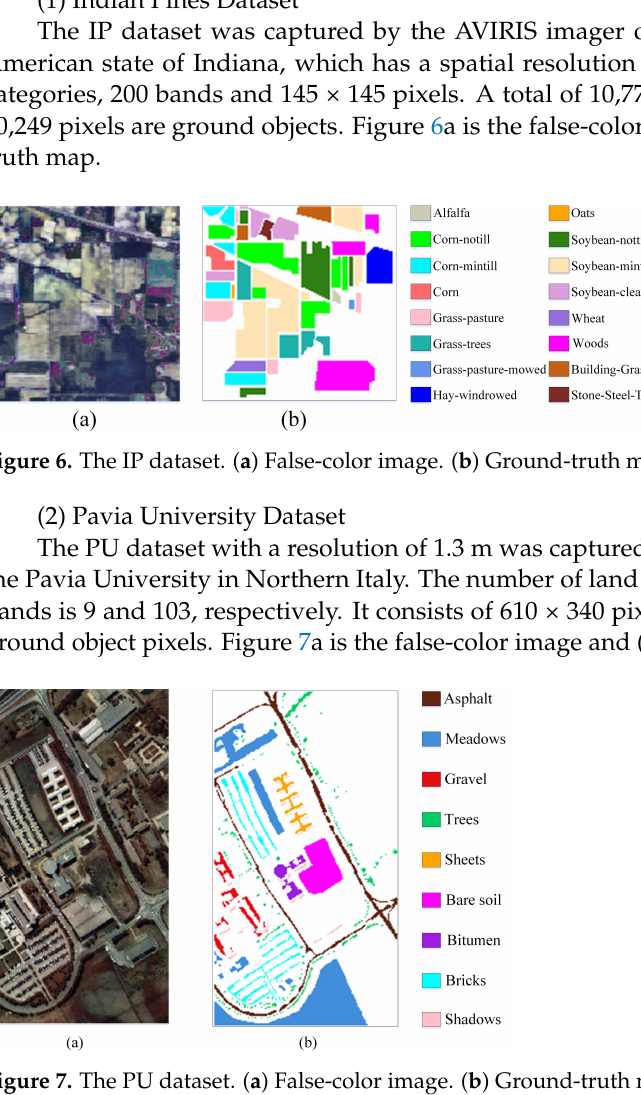
Figure 7. The PU dataset. ( a ) False-color image. ( b ) Ground-truth